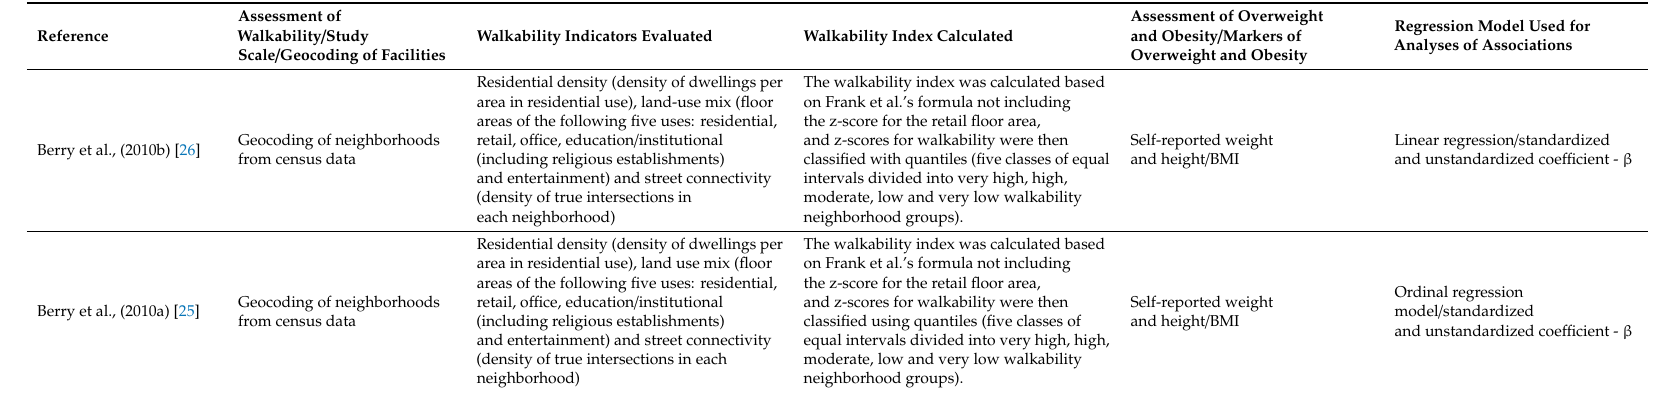
Table 2. Methodological characteristics of the descriptive